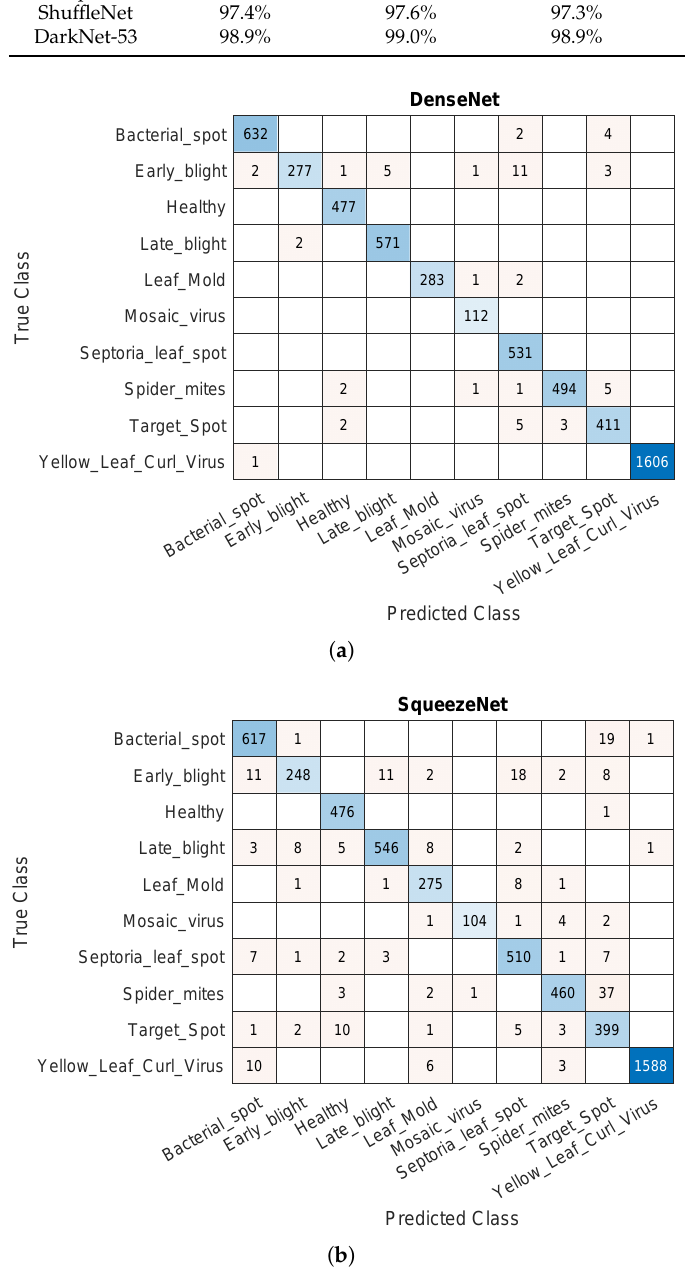
Figure 5. Sample confusion matrices for the best (DenseNet-201) and the worst (SqueezeNet) per- forming models using 70% of the data for training. ( a ) DenseNet-201; ( b )